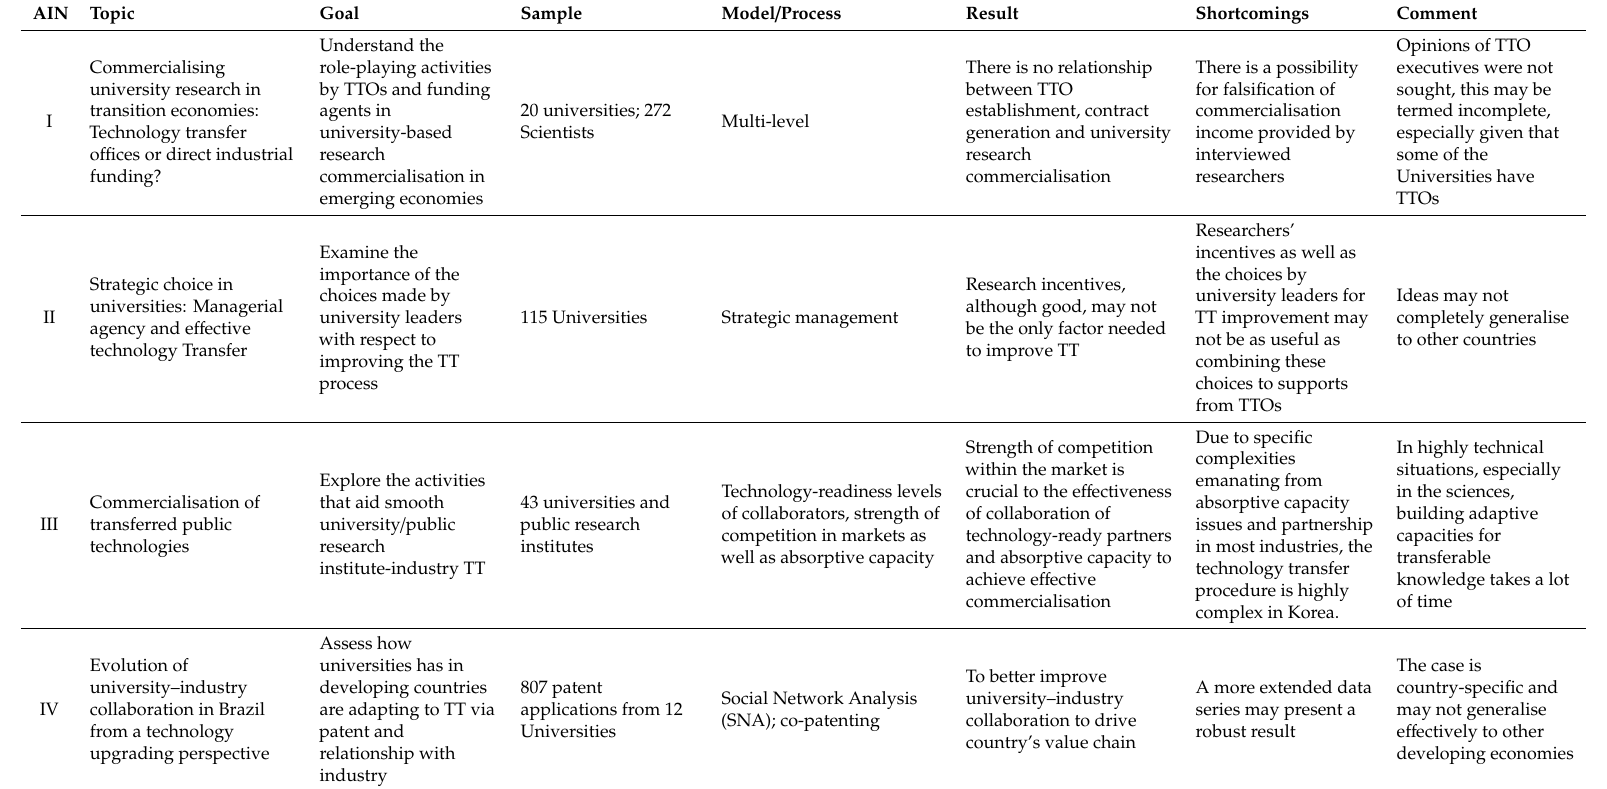
Table 4. Summary of selected